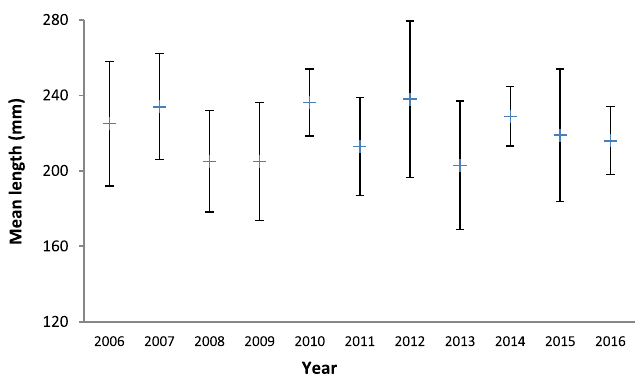
Fig. 1. Average annual mean length (mean±SD) of S. undosquamis harvested by trawl nets along the southeastern Arabian Sea during 2006 –